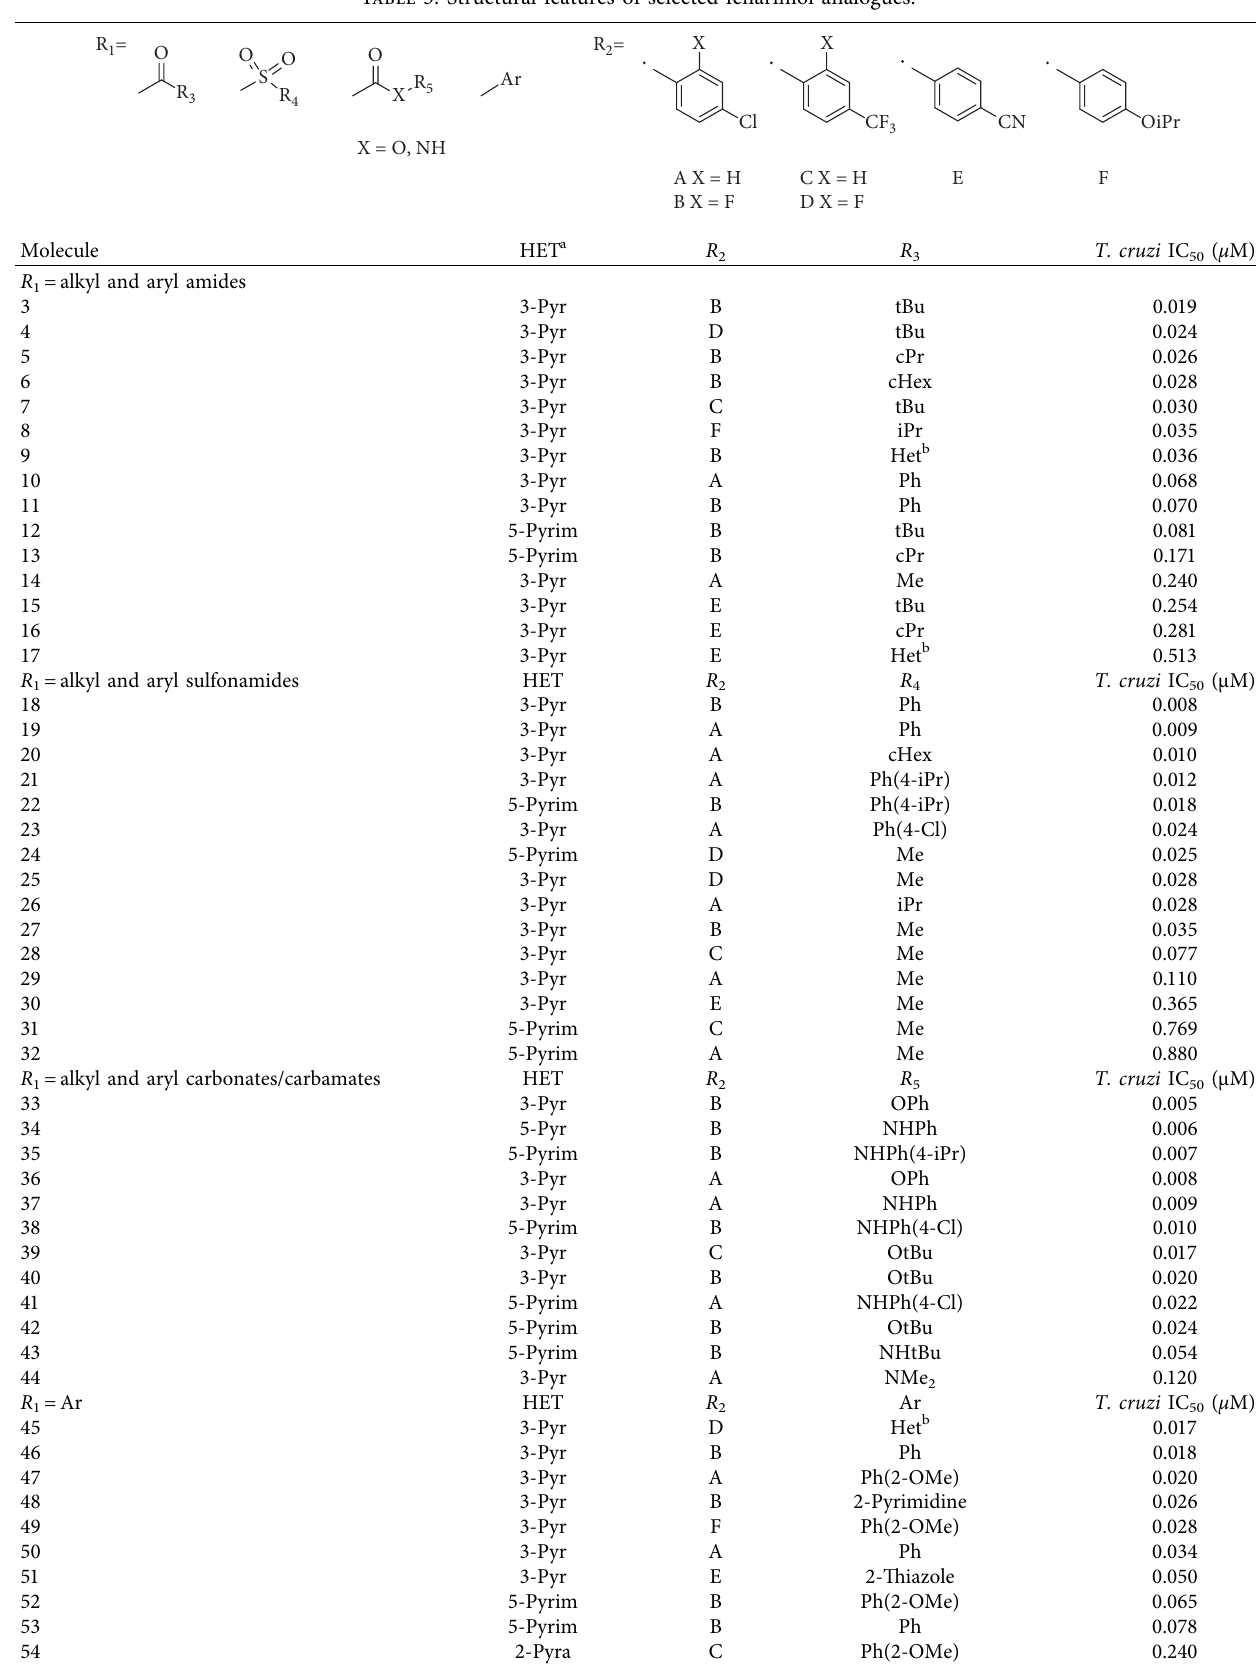
Table 3: Structural features of selected fenarimol